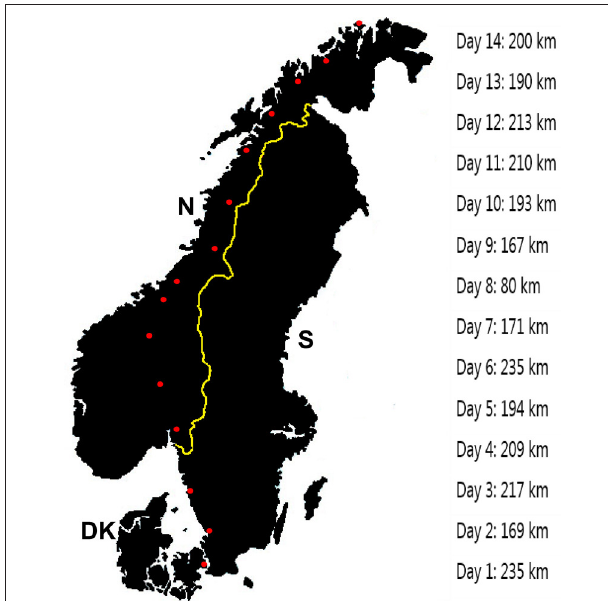
FIGURE 1 | Geographical depiction of the 2,706 km (1,681 miles) route from Copenhagen, Denmark, to North Cape, Norway, via Sweden. The red dots depict departure and arrival points of daily stages throughout the trip. Daily stage distances in kilometers are shown from days 1 to 14. DK, Denmark; N, Norway; S, Sweden. Used by permission